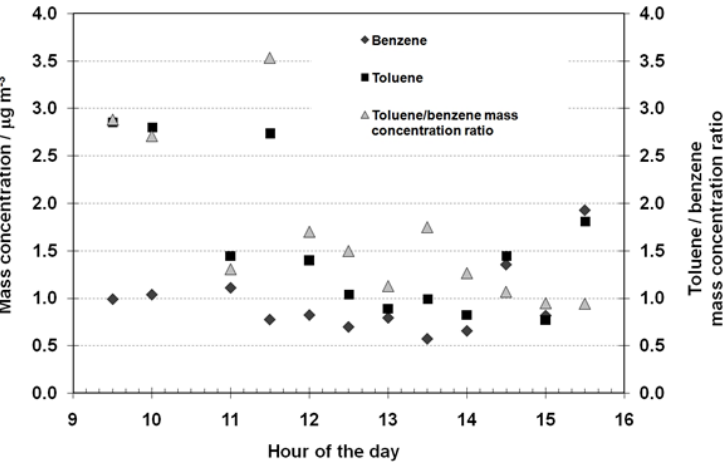
Figure 4. Average hourly variations of mass concentrations of toluene and benzene during the growing season 2005 and their ratio at Mali Lošinj.